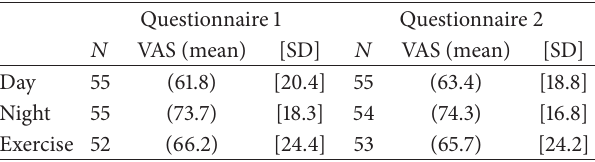
Table 1: Preoperative test-retest VAS